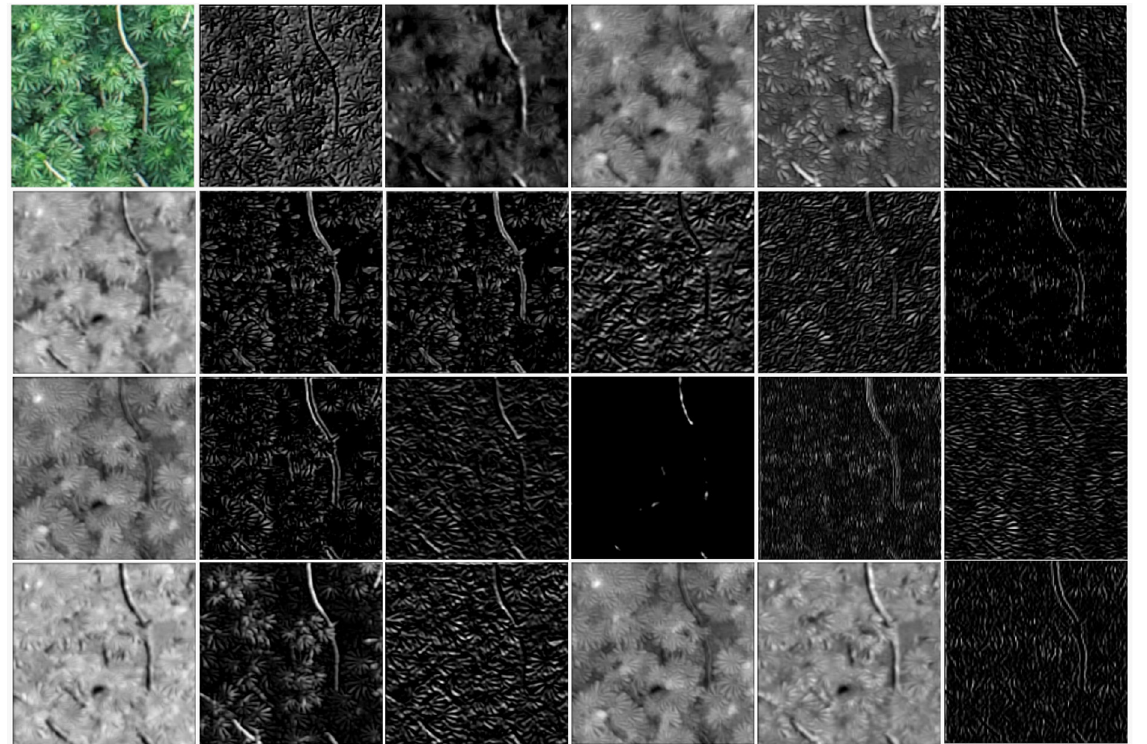
Figure 3. Representation of transformations that CNN make internally for Cecropia juranyiana C.Mart